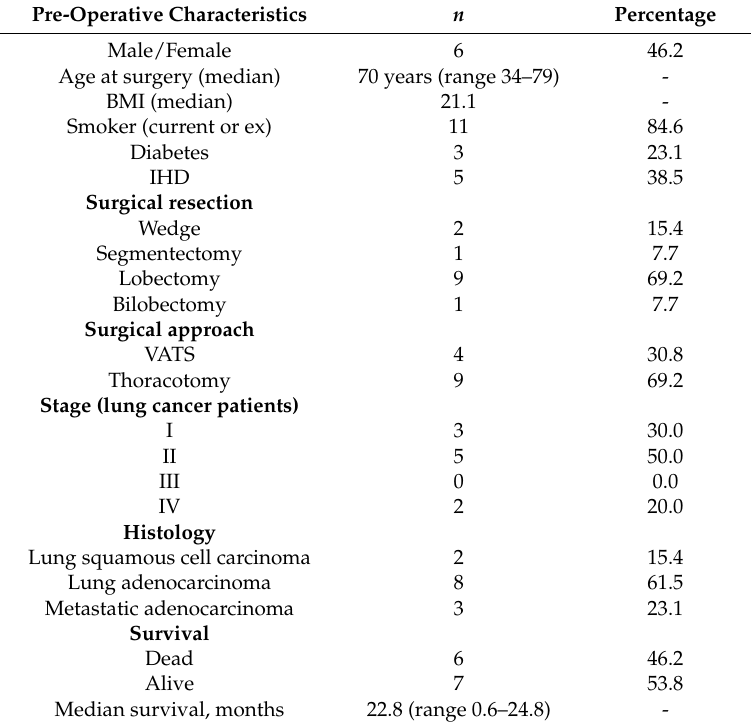
Table 1. LC patient demographics for the CTC study.